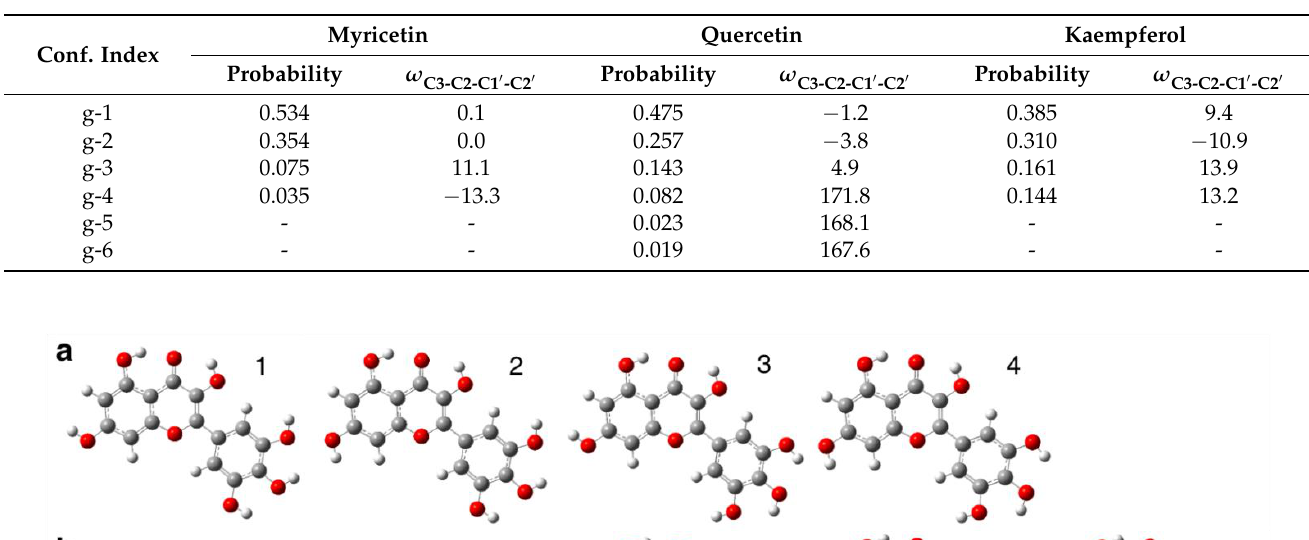
Table 1. Relative population (probability) and dihedral angles of C3-C2-C1 (cid:48) -C2 (cid:48) after the geometry optimization with DFT for each conformer. The values of ω C3-C2-C1 (cid:48) -C2 (cid:48) are shown in degrees.